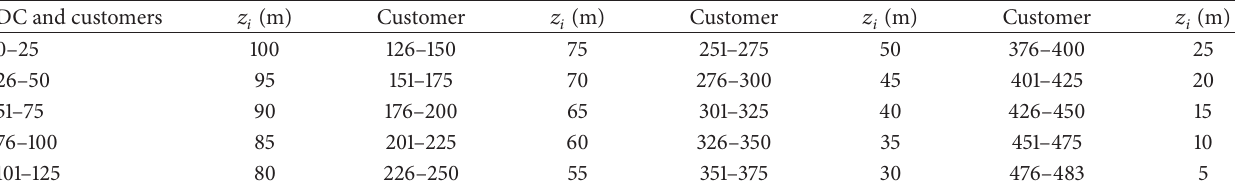
Table 4: The 𝑧 𝑖 values for DC and customers 1–483 of 20 instances.